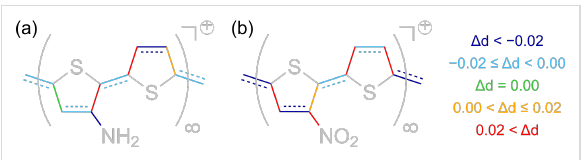
Figure 10: Color-coded change of bond lengths in (a) NH 2 PTp and (b) NO 2 PTp for positively charged polymers with the number of electrons per unit cell lowered by